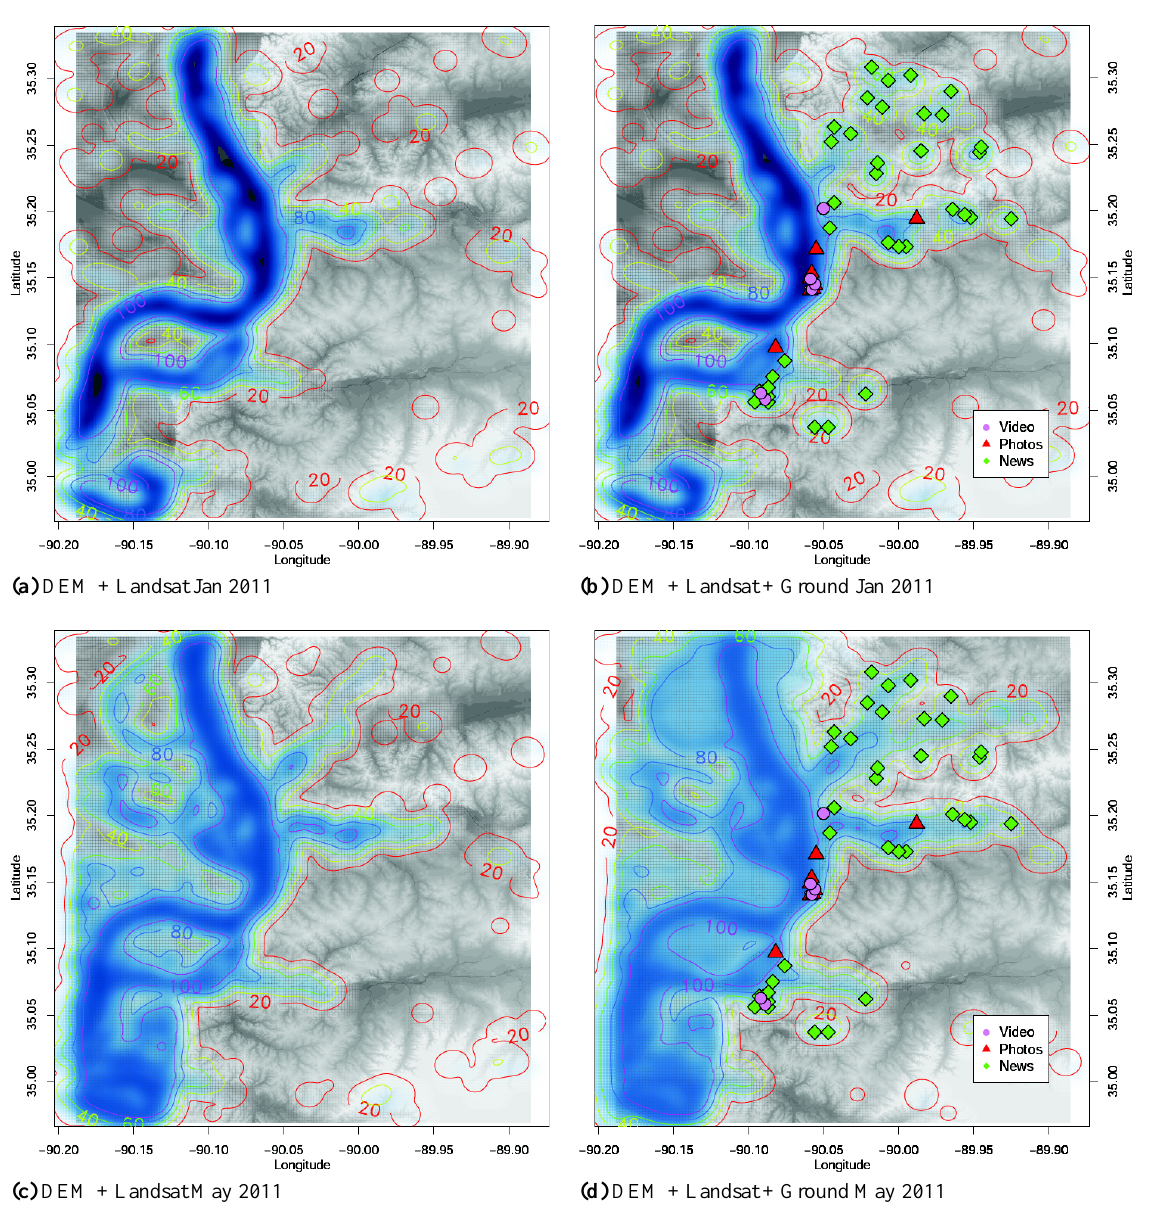
Fig. 6. Flood hazard map indicating the probability of flood in percentage using DEM, Landsat, and ground data for January 2011 ( a and b ) and for May 2011 ( c and d